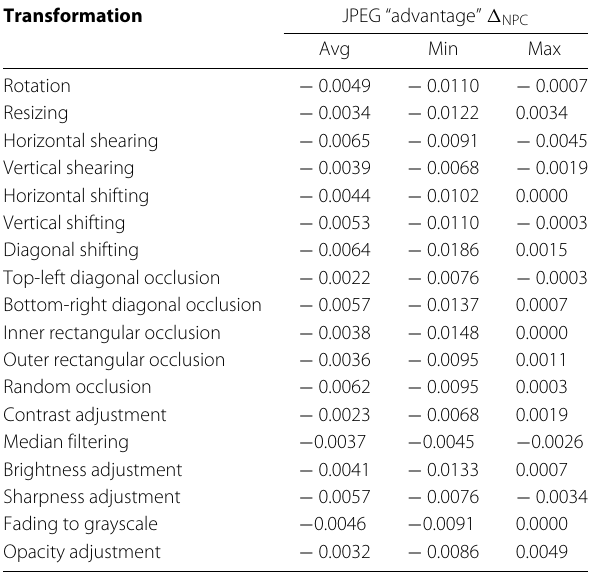
Table 4 Statistics of (cid:7) NPC over different parameters when JPEG recompression is